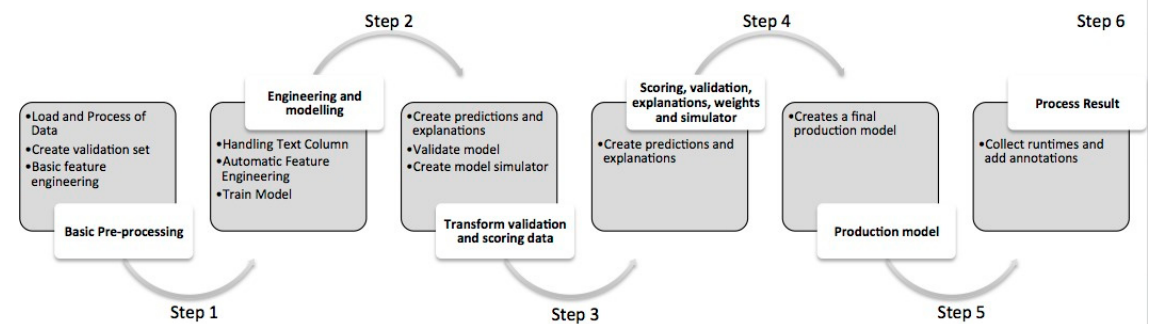
Figure 2. Six steps of the Gradient Boosted Trees (GBT) model’s processes.